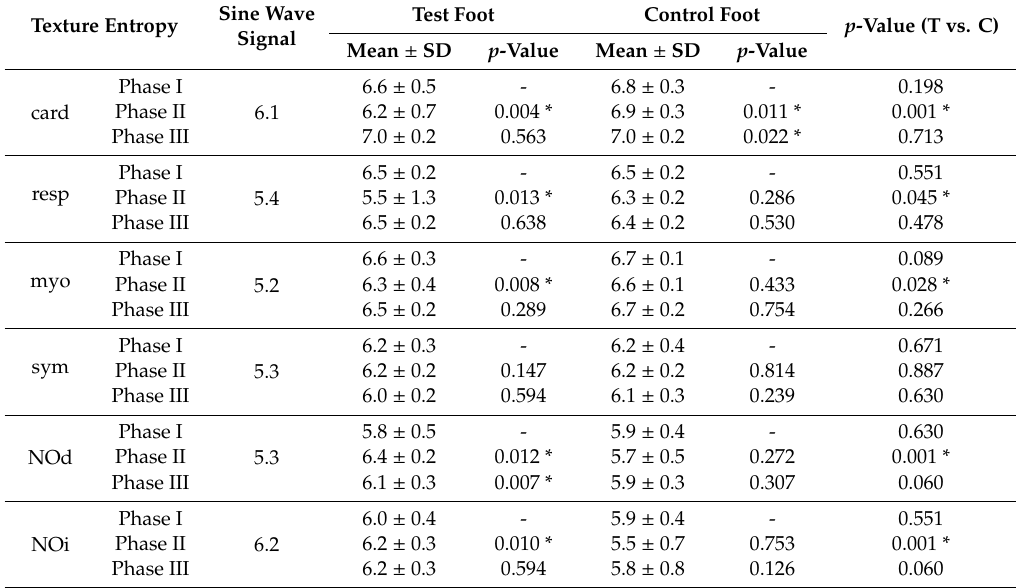
Table 2. Mean and standard deviation (SD) of the texture entropy for each foot on each phase of the protocol (card—cardiac, resp—respiratory, myo—myogenic, sym—sympathetic, NOd—endothelial NO-dependent, NOi—endothelial NO-independent). Statistical comparison to Phase I and between the test and control limbs are shown (*— p <